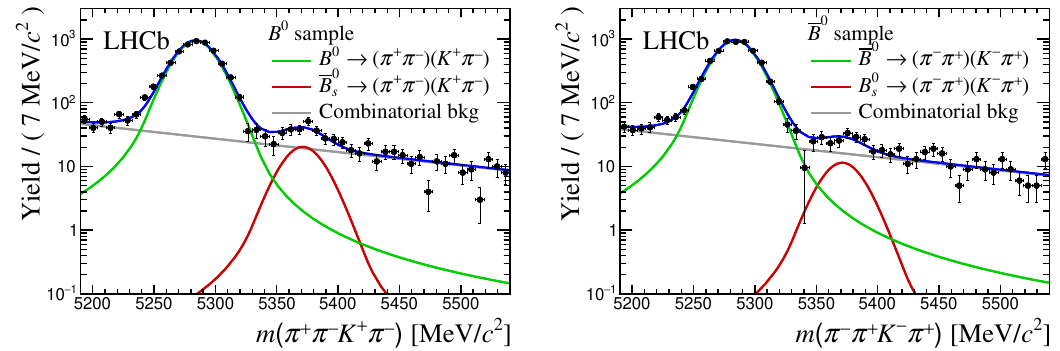
Figure 2. Fit to the invariant-mass distribution of selected (left) B 0 and (right) B 0 candidates after the subtraction of B 0 K (cid:3) 0 K (cid:3) 0 background decays. The four trigger and data-taking year s ! categories are aggregated in the (cid:12)gures. The contributions due to the B 0 ( (cid:25) + (cid:25) (cid:0) )( K + (cid:25) (cid:0) ) signal, ! B 0 ( (cid:25) + (cid:25) (cid:0) )( K + (cid:25) (cid:0) ) background and combinatorial background are represented by the solid green, s ! red and grey lines, respectively. Data are shown using black dots and the overall (cid:12)t is represented by the solid blue